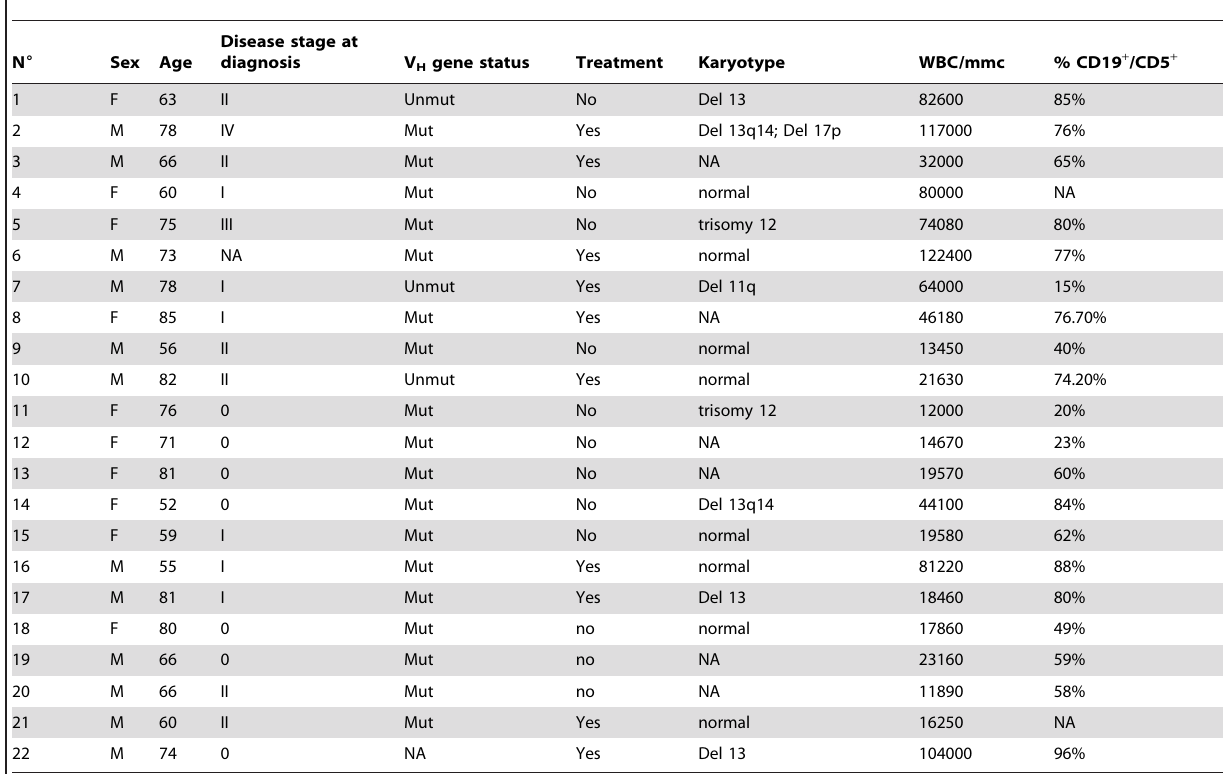
NA indicates not available.